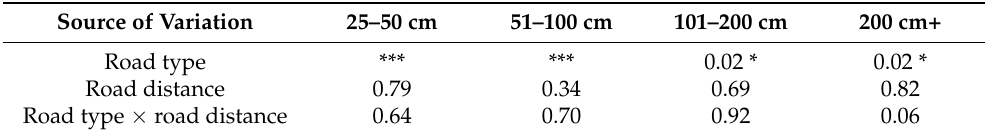
Table 5. Results of the two-way ANOVA of the basal gap of perennial plants (road type, distance, and their interaction).